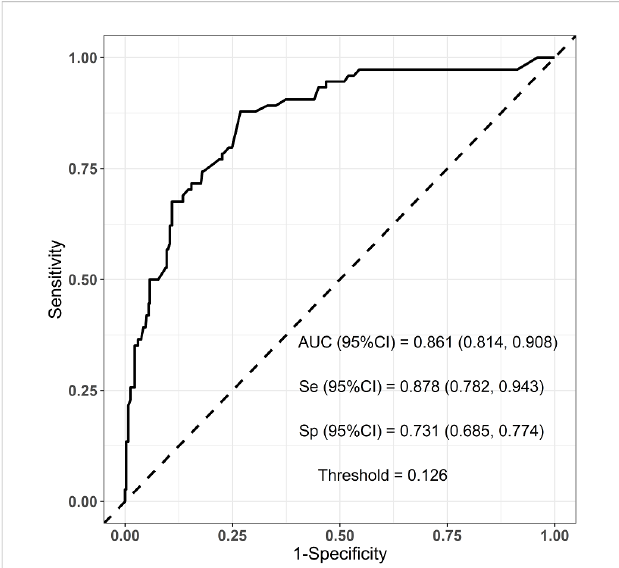
FIGURE 3 ROC analysis for predicting rapid relapse in the validation set. ROC, receiver operating characteristic; AUC, area under the